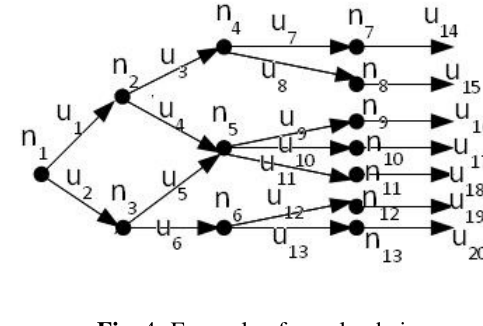
Fig. 4: Example of supply